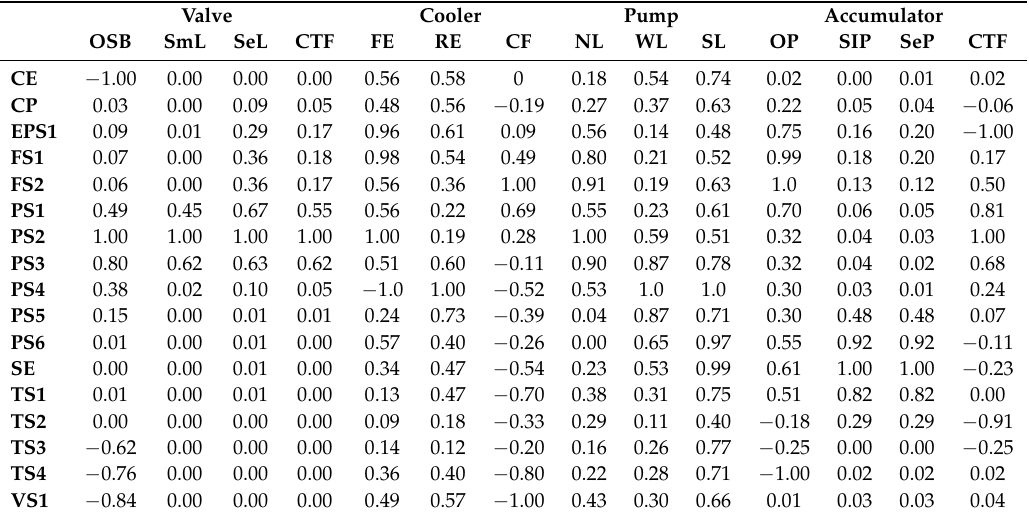
Table 10. Maximum attribution by sensor and degradation